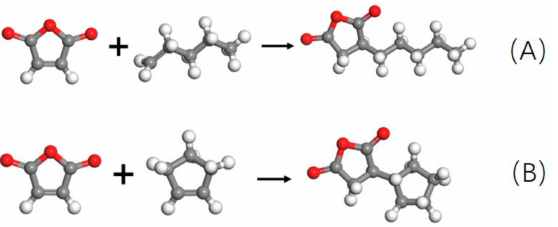
Figure 3. Maleic anhydride and 1-pentene composite monomer ( A ). Maleic anhydride and cyclopen- tene composite monomer ( B